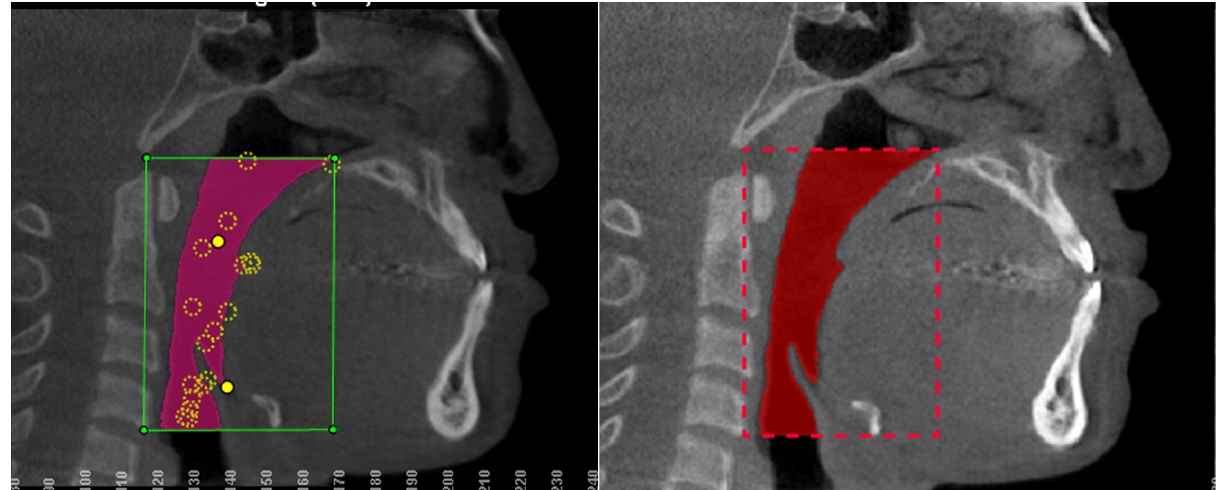
Figure 1- Rectangle formed by the selected anatomic points. On the left, image from Dolphin3D software and, on the right, image from ITK-Snap